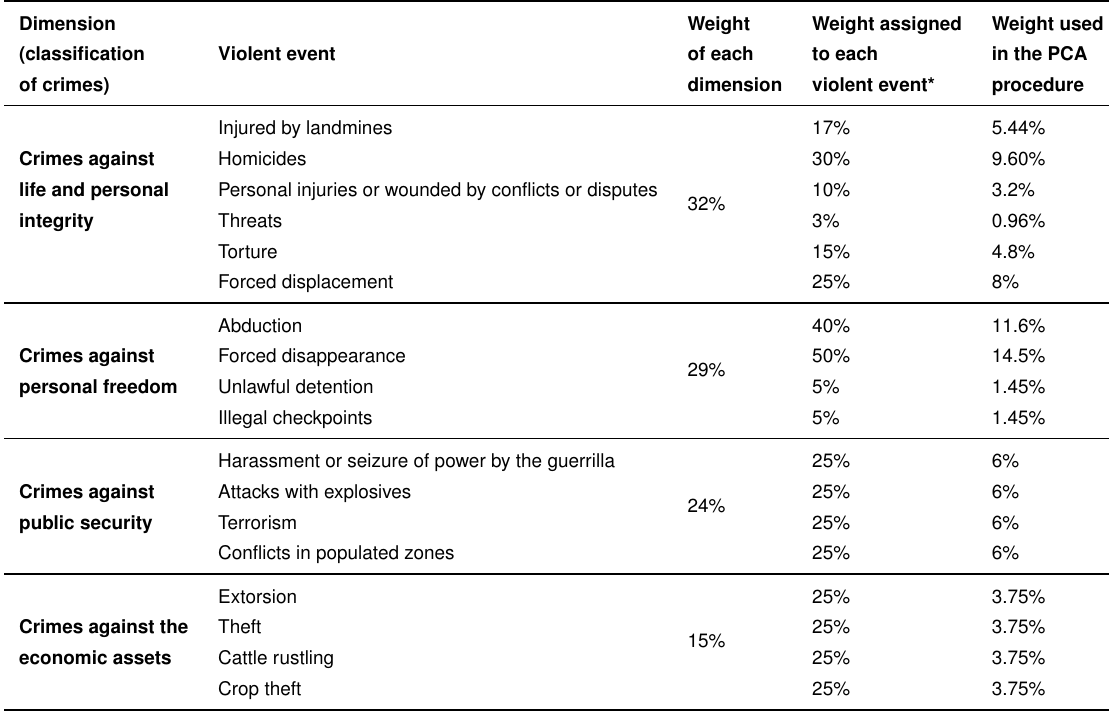
Table 1. Weights allocated by experts to each dimension of the crime, each violent act, and the PCA’s weight. (*Percentage in relation to the weights of each dimension).